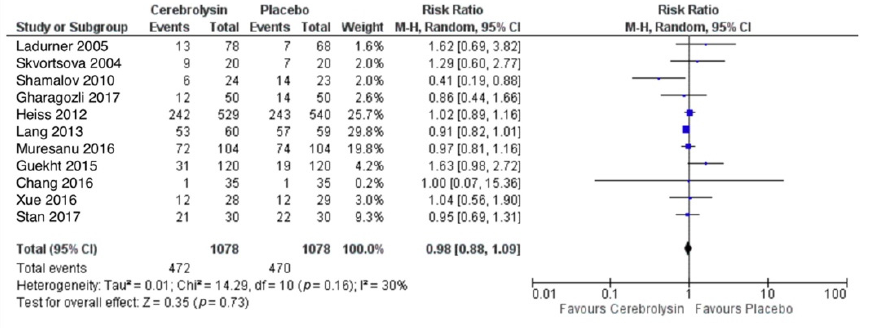
Figure 4. Adverse events (patients with at least one AE); Comparison of Cerebrolysin versus Placebo in the Safety Population, Random Effects, M-H, Risk Ratio (RR).